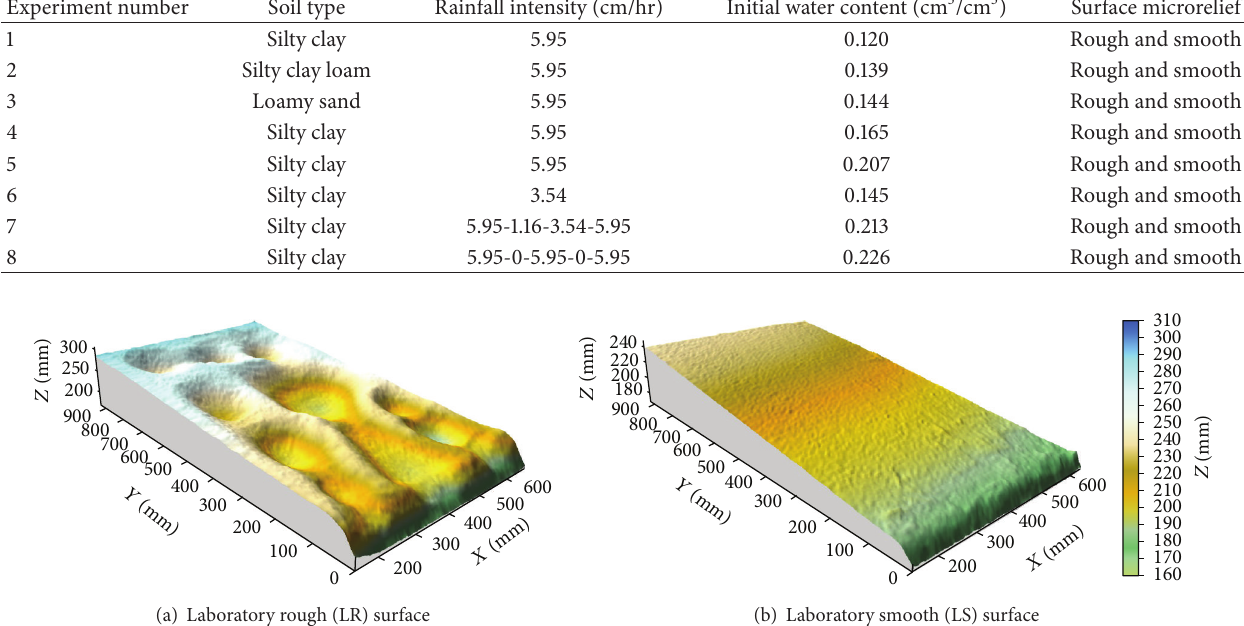
Table 1: Details on the laboratory overland flow experiments.